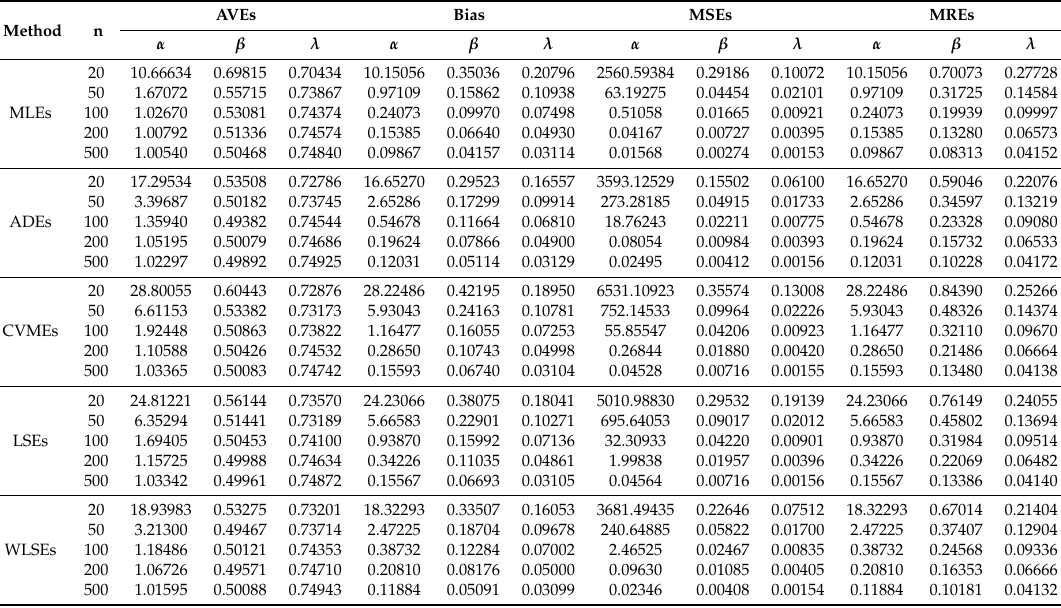
Table 4. Simulation values of the AVEs, biases, MSEs, and MREs for ( α = 1, β = 0.5, λ = 0.75 ) .